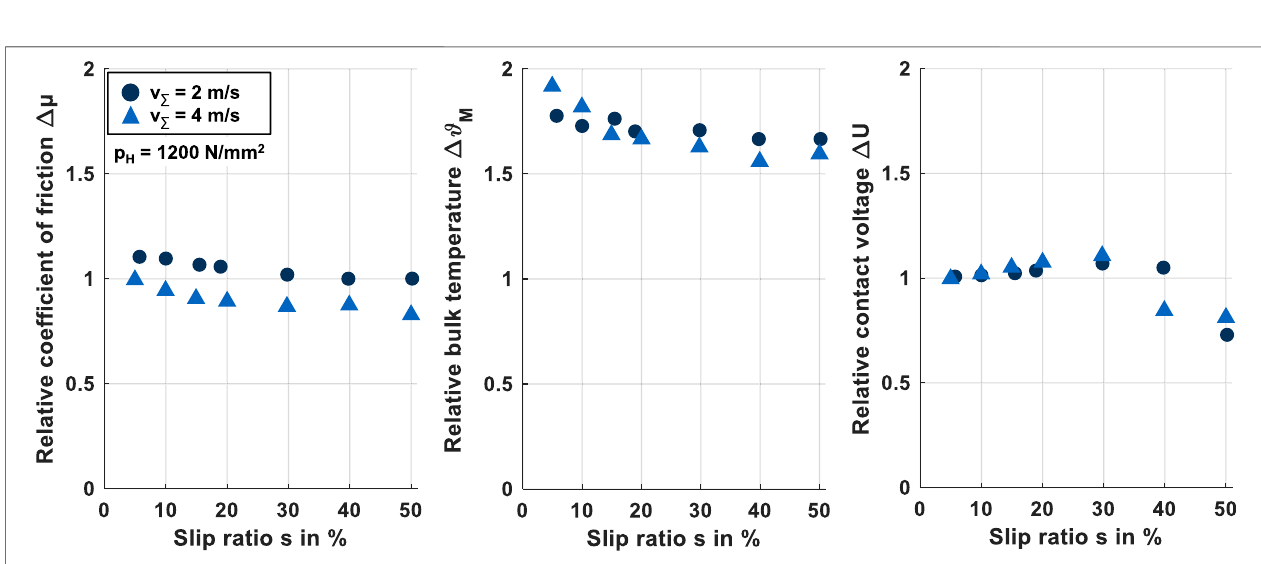
FIGURE11| ComparisonofDoDandinjectionlubricationatthetwin-disktribometerbyrelativequantities Δ µ, Δ ϑ M and Δ Uoverslipratiosforp H (cid:1) 1200 N/mm 2 andv Σ (cid:1) {2,4} m/s.